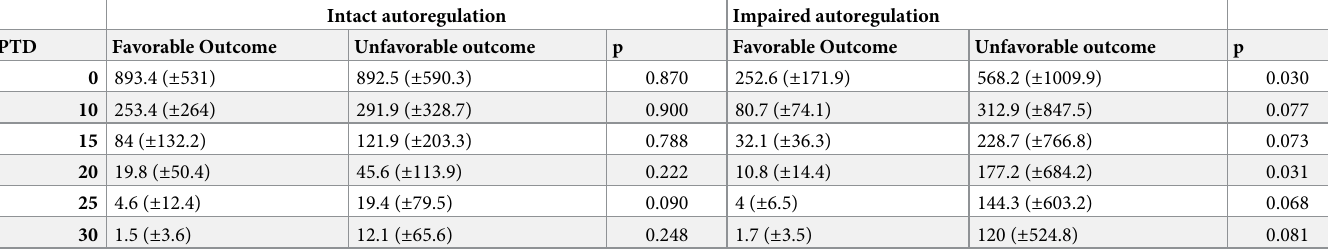
Table 3. Group mean PTD (mmHg � h) of intact or impaired autoregulation above thresholds of ICP, favourable vs unfavourable outcome. Intact autoregulation